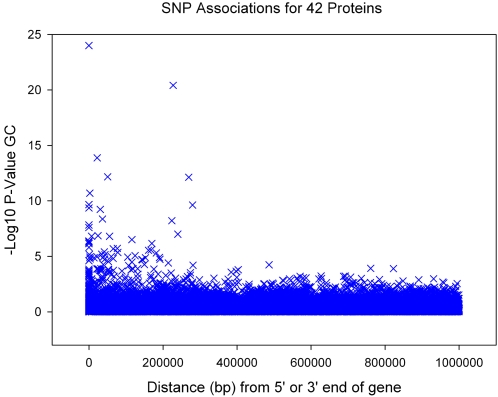
Association of SNPs 1Megabase from each cis gene.For each SNP the X axis represents the distance in base pairs from either the 5′ or 3′ end of the gene. If SNPs occur within the gene, either in introns or exons, they are given a distance of zero. SNPs in IL6R <1×10−25 not shown.